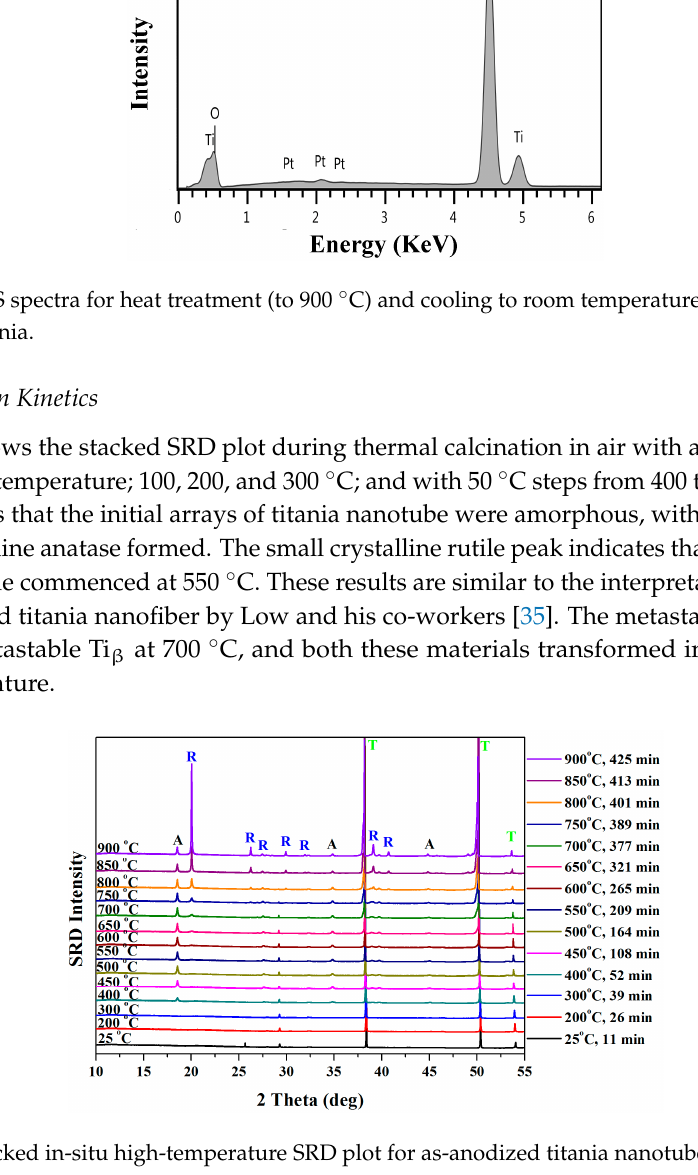
Figure 2. FESEM micrographs for anodized titania nanotube arrays ( a ) after the anodization process (60 V, 25 °C, 20 h), and following SRD experiments and viewed with ( b ) low, and ( c ) high magnification.